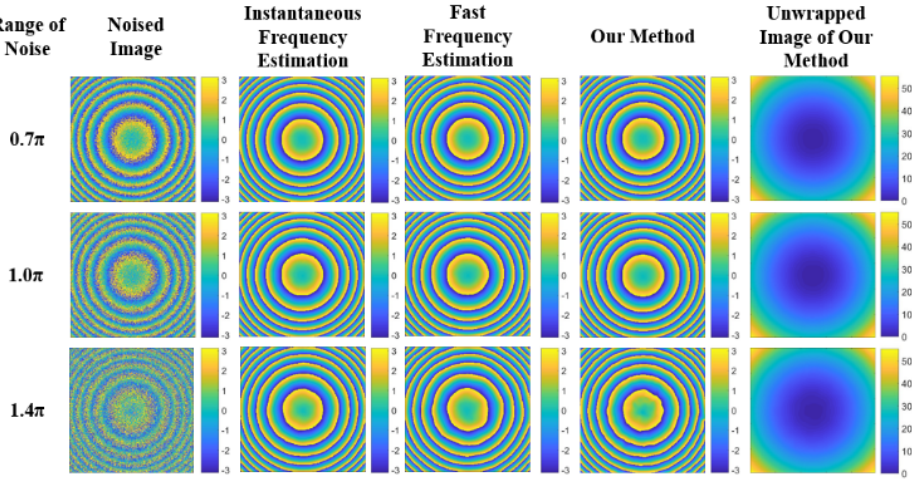
Figure 8. The noised spherical aberration phase map and its corresponding filtered and rewrapped results. Table 1. Mean-squared error (MSE) of each filtering method in Figure 8. Range